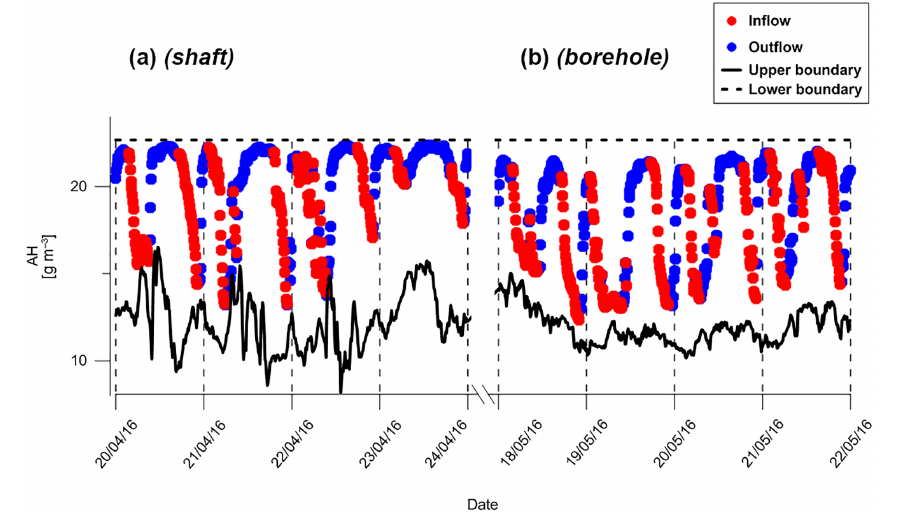
Figure 3. Classification of inflow and outflow transition events at 12m of depth for the shaft (a) and borehole (b) . The upper boundary represents the AH values according to the temperature and RH measured at 2m aboveground; the lower boundary represents the AH values in the underground cavity (shaft) or the soil–borehole interface (borehole). Point intervals are at 10min each.